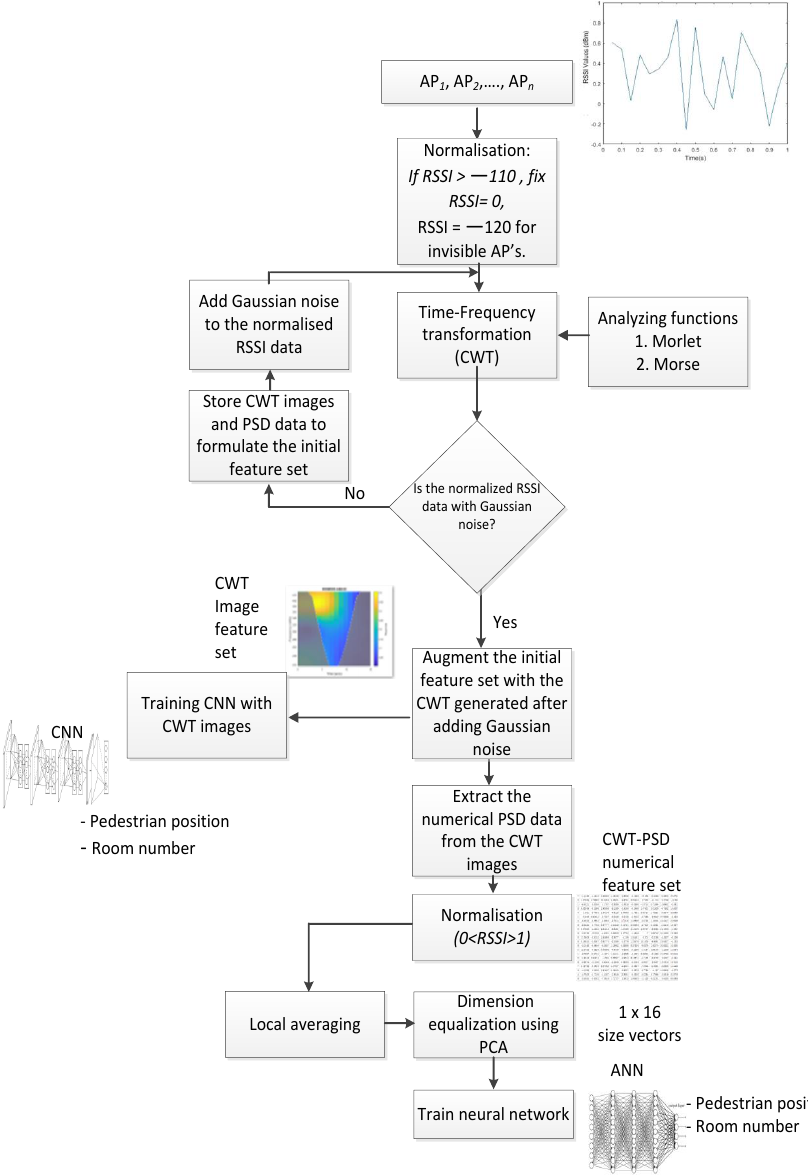
Figure 4. Generation of the augmented CWT features